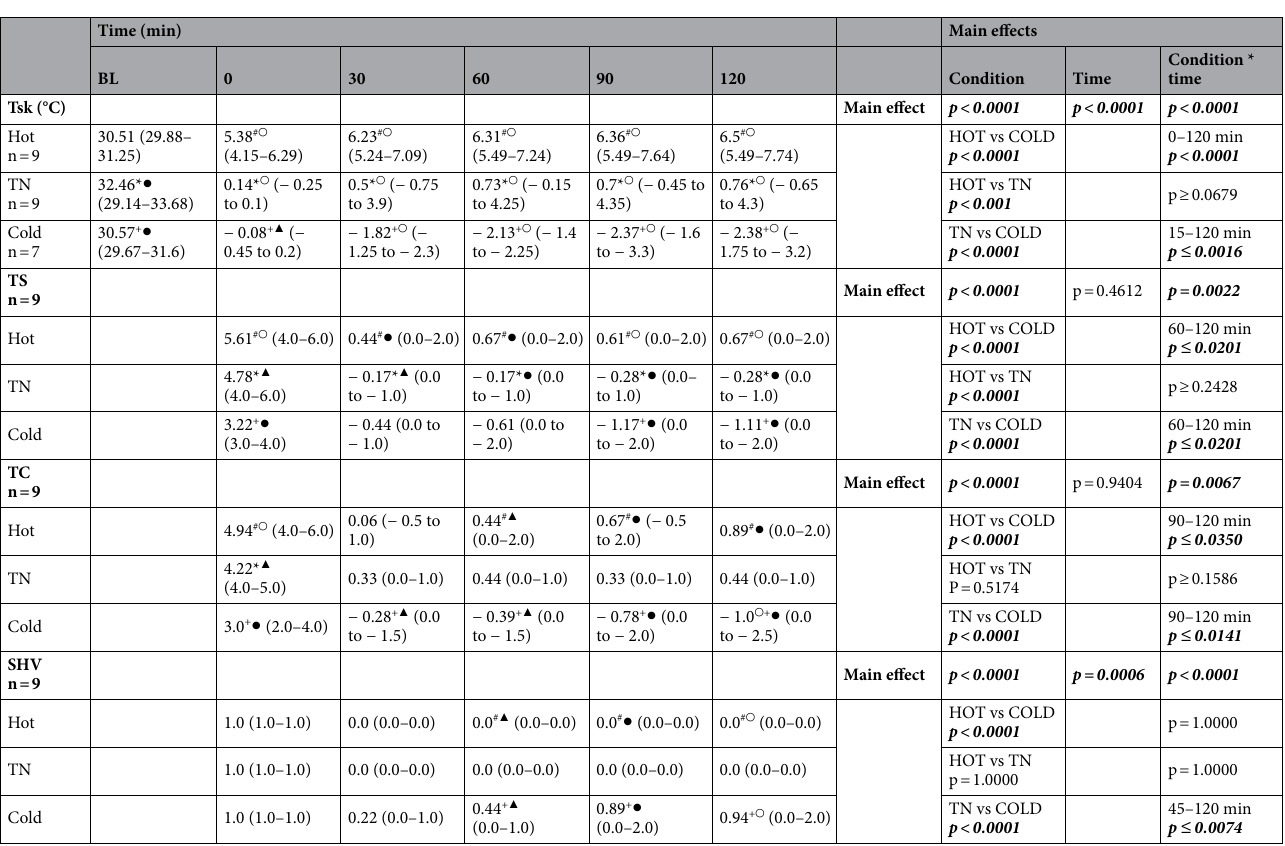
Table 4. Mean skin temperature and thermal perception Δ changes across time. Values expressed as mean (range). Raw BL values presented for context thermal perceptions (1–7 scale) were only recorded during the experimental period (0–120 min)]. Results are presented every 30 min for clarity. Symbols are used to denote significant between condition interactions (e.g. *Hot vs TN, # Hot vs Cold, + TN vs Cold) and the